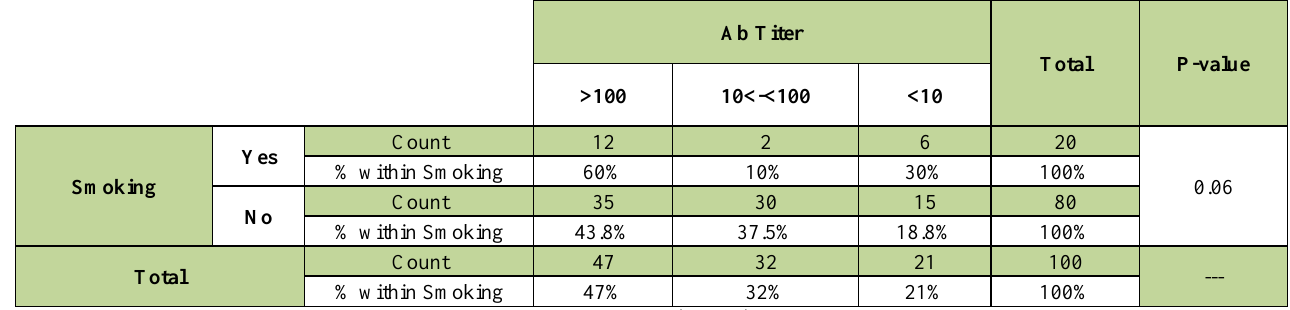
Table 9. Analysis of the relationship between the anti-hepatitis B titers in patients with